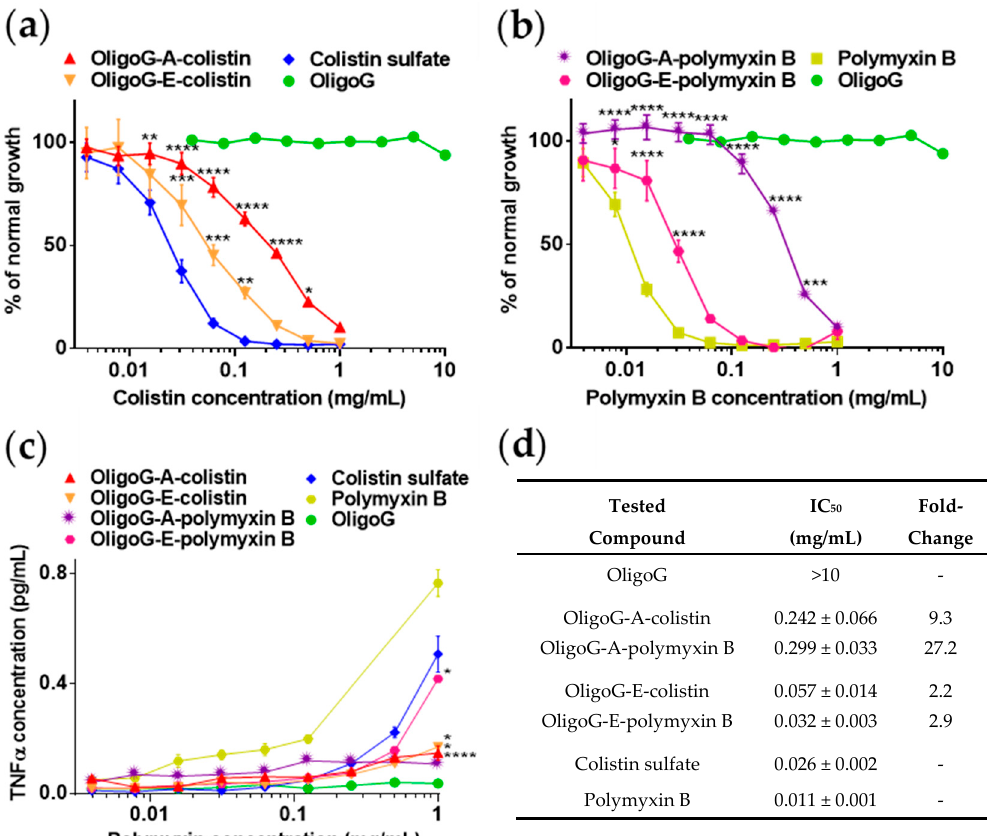
Figure 1. In vitro cytotoxicity of OligoG–polymyxin conjugates in human kidney proximal tubule (HK-2) cells. Cell viability determined by 3-(4,5-dimethylthiazol-2-yl)-2,5-diphenyltetrazolium bromide (MTT) assay after 72 h incubation. ( a ) Colistin sulphate. ( b ) Polymyxin B. Data are presented as mean % of untreated control ± SEM ( n = 18). ( c ) Tumour necrosis factor alpha (TNF α ) release in HK-2 cells after incubation with OligoG–polymyxin conjugates for 72 h ( ± SEM; n = 6). ( d ) Half maximal inhibitory concentration (IC 50 ) values ( ± SEM) and fold-change (MTT assay) of tested compounds in HK-2 cells. Significance is indicated by *, where * p < 0.05, ** p < 0.01, *** p < 0.001, **** p < 0.0001 compared to colistin sulphate or polymyxin B controls. Abbreviations: A, amide; E, ester.